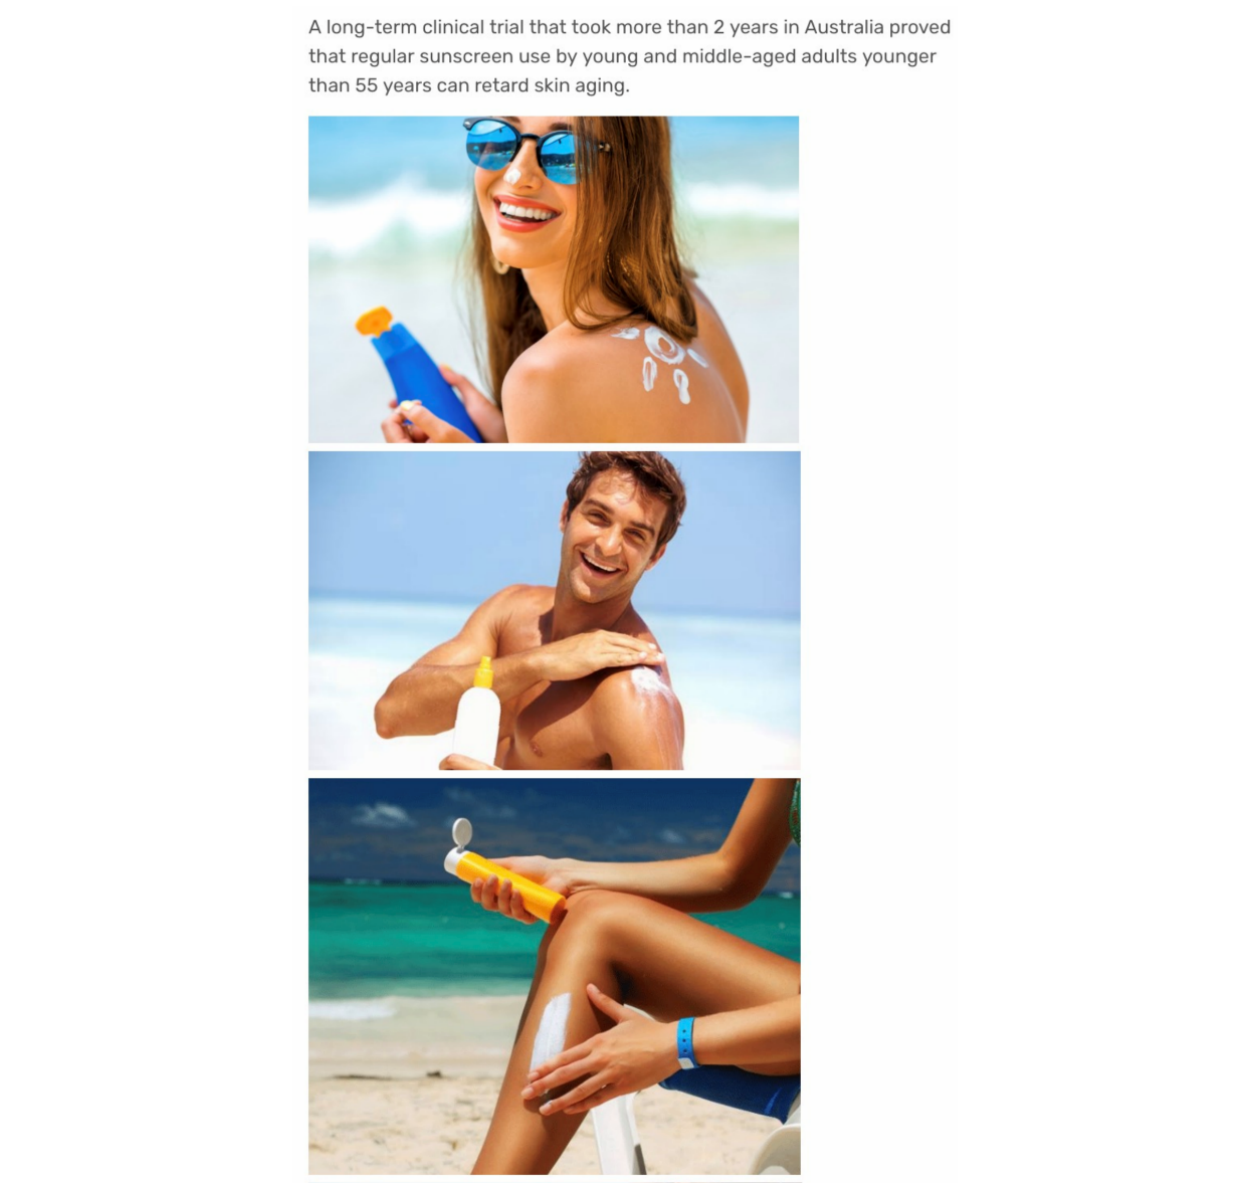
Figure 3. Screenshot of the webpage of low interactivity and human presence